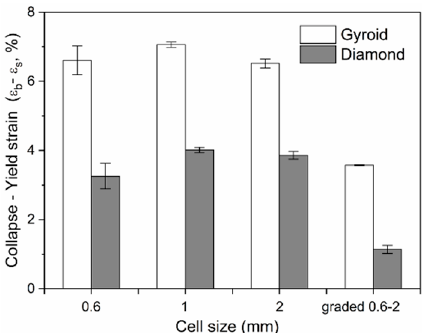
Figure 13. Comparison of the collapse–yield strain ( ε b − ε s ) of Gyroid and Diamond scaffolds with cell sizes ranging from 0.6 to 2 mm.